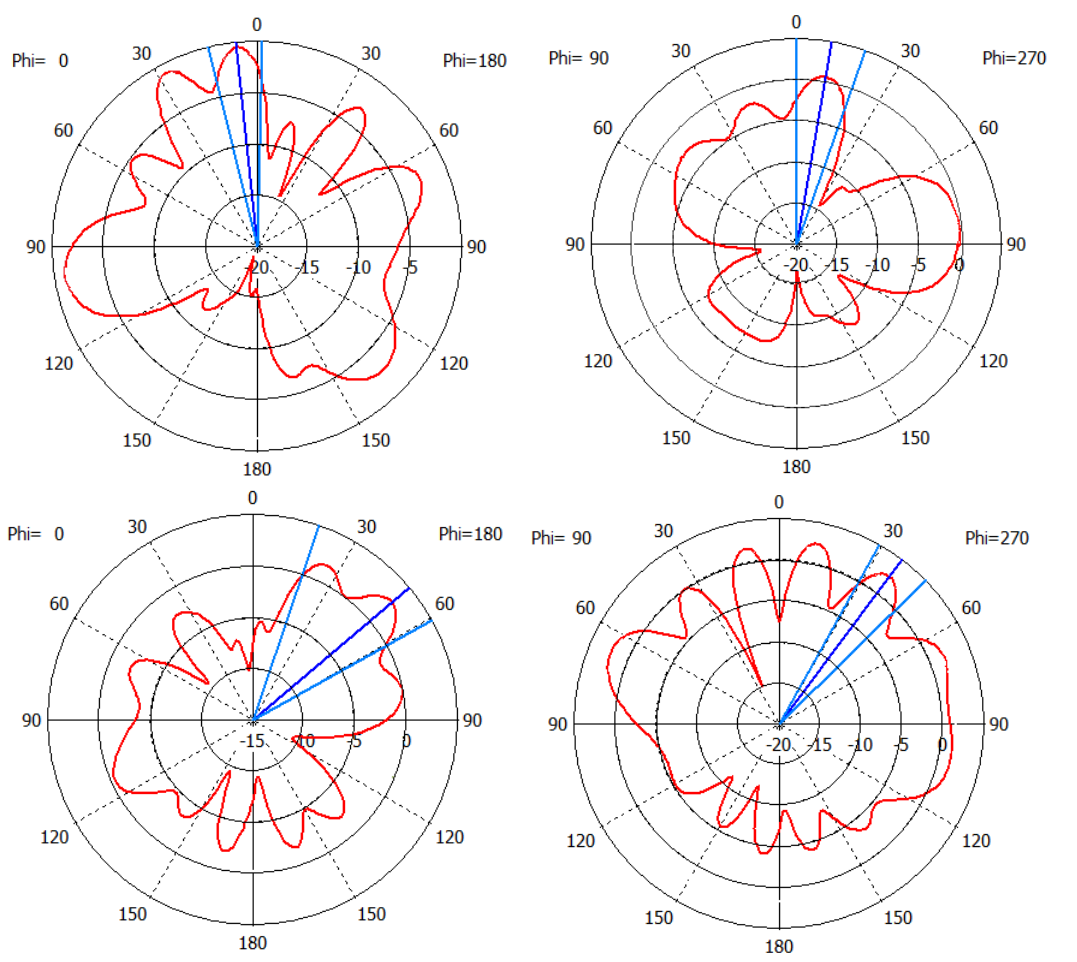
Figure 6. Co-pol radiation pattern of the considered antenna in the E—( left ) and H—( right ) planes at 4.5 GHz ( top ) and 6.2 GHz ( bottom